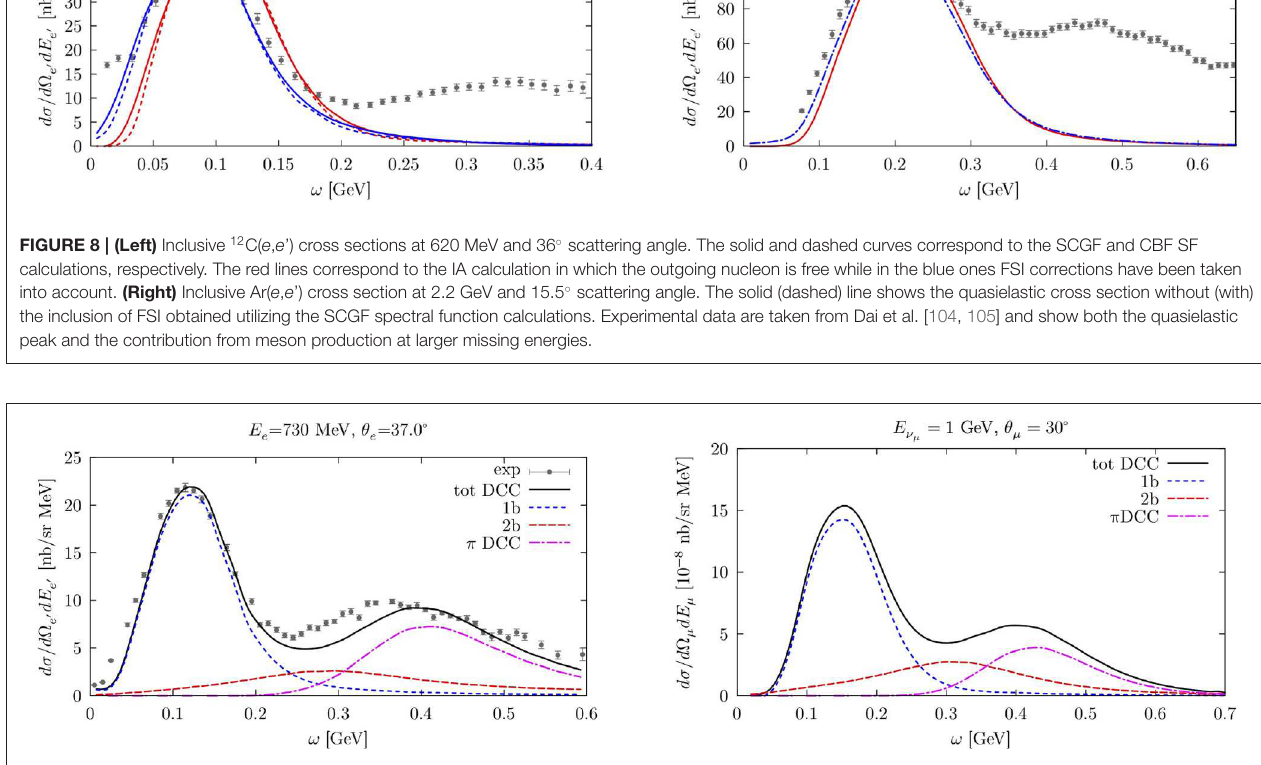
FIGURE 9 | (Left) Inclusive 12 C( e , e ’) cross sections at 730 MeV and 37 ◦ scattering angle. The short-dashed (blue) line and dashed (red) line correspond to one- and two-body current contributions, respectively. The dash-dotted (magenta) lines represent π production contributions. The solid (black) line is the total results obtained summing the three different terms. (Right) Same as left panel but for CC ν µ scattering on 12 C. The energy of the ν µ is 1 GeV and the scattering angle is 30 ◦ .